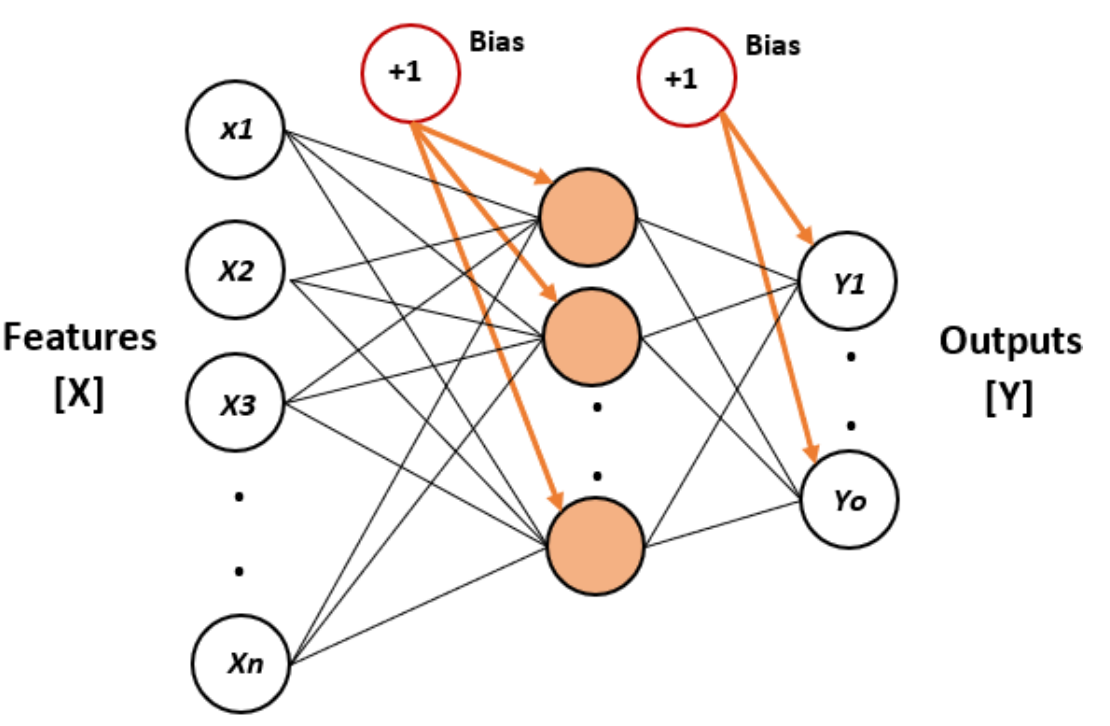
Figure 3. One hidden layer neural network structure.